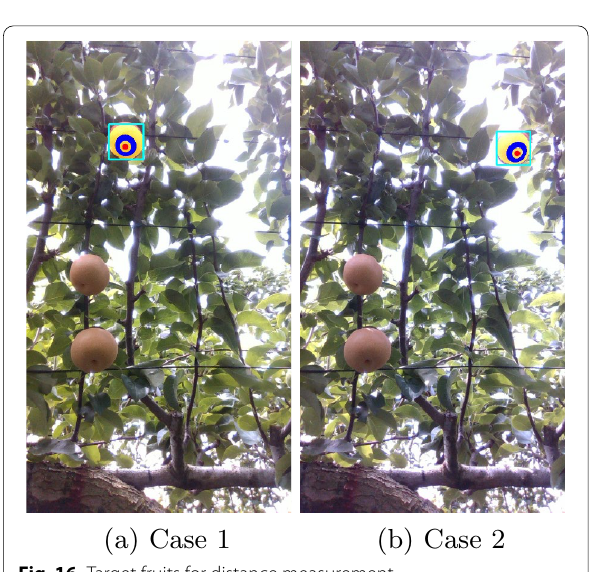
(a) Case 1 (b) Case 2 Fig. 16 Target fruits for distance measurement